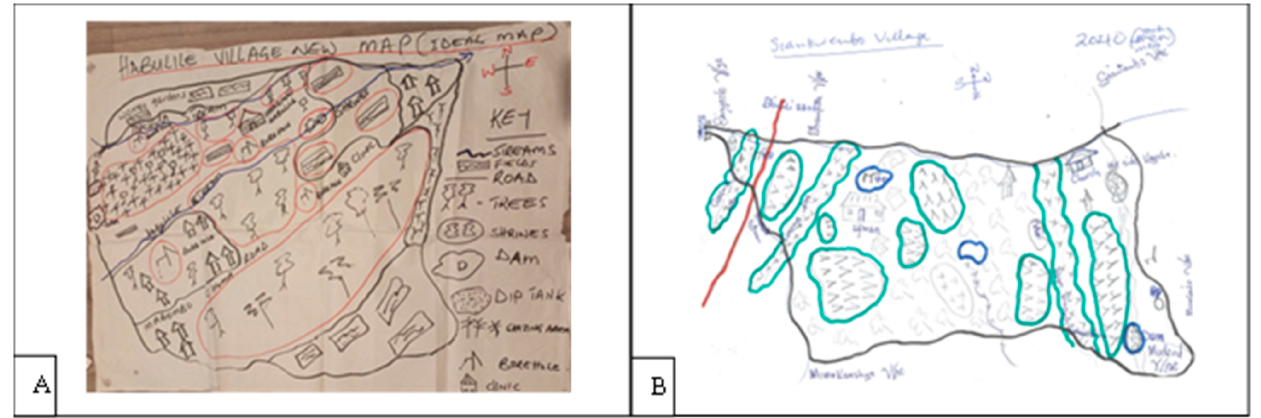
Figure 5. Combined participatory maps of the envisioned future landscapes in MSP1 ( A ) and MSP2 ( B ). (Note: di ff erent colours were used to delineate boundaries of various land-cover types).